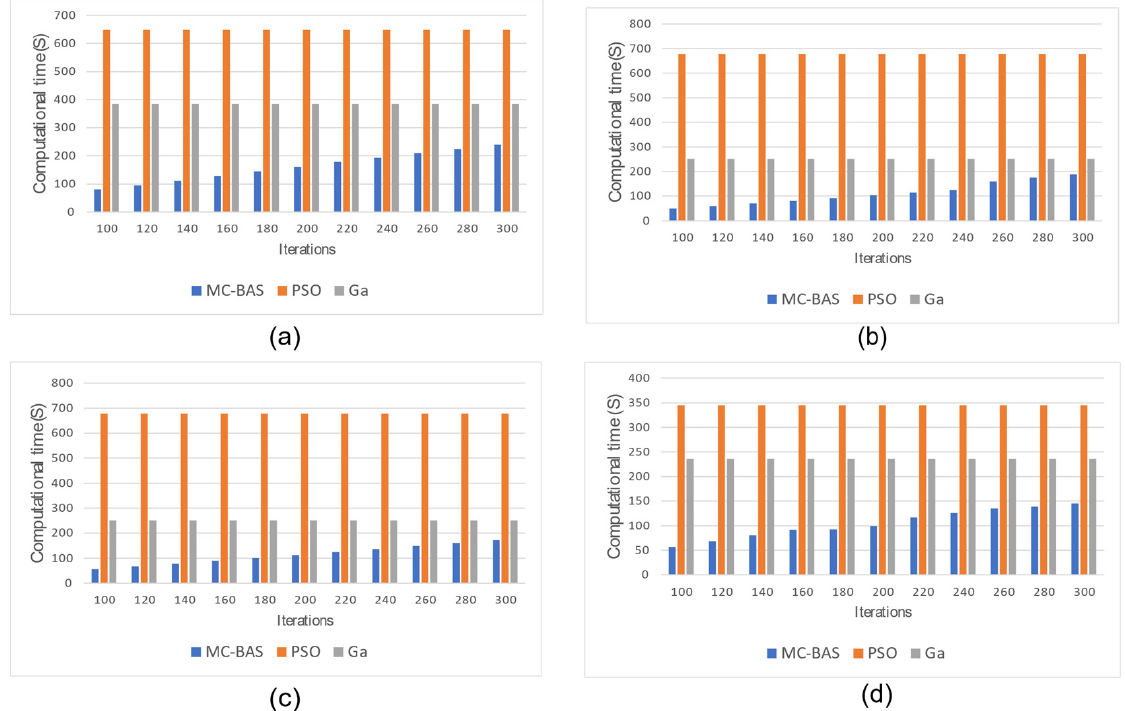
Figure 9. The computational time versus iteration of different algorithms in 3 × 3 matrix OWF: ( a ) ϕ = 0 ◦ ; ( b ) ϕ = 25 ◦ ; ( c ) ϕ = 45 ◦ ; ( d ) ϕ = 90 ◦